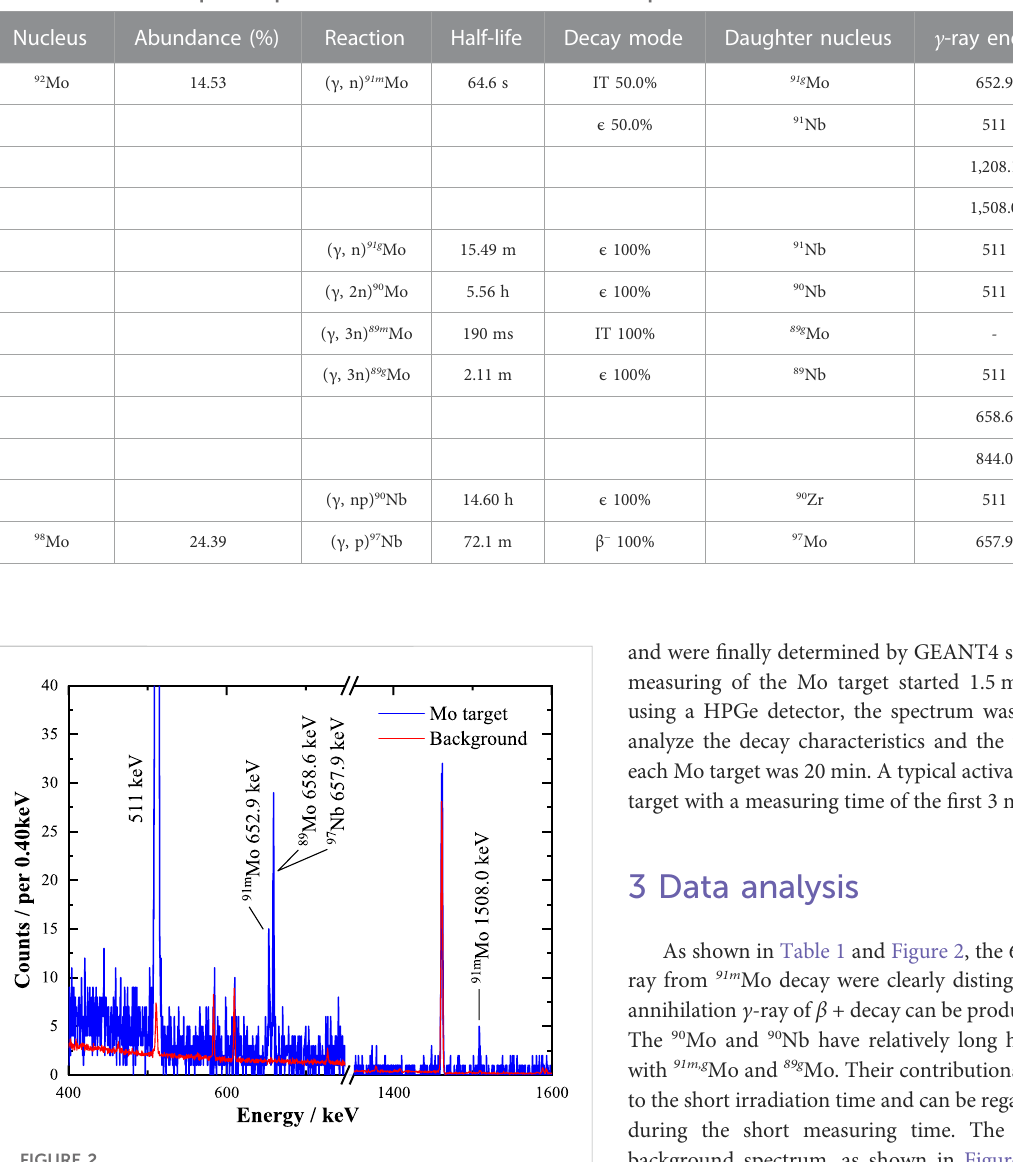
FIGURE 2 A typical spectrum of Mo target at gas pressure of 33 bar. The background spectrum measured for 5 h with a blank Mo target was also showninthe fi gure, thespectrum countswerenormalizeddueto the living